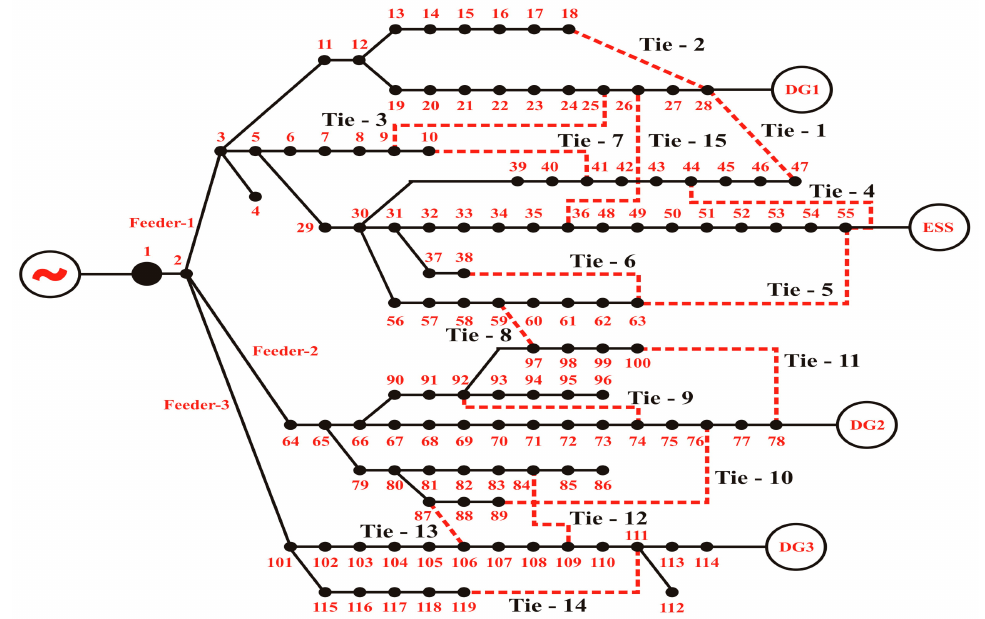
Figure 9. IEEE 119-bus system.